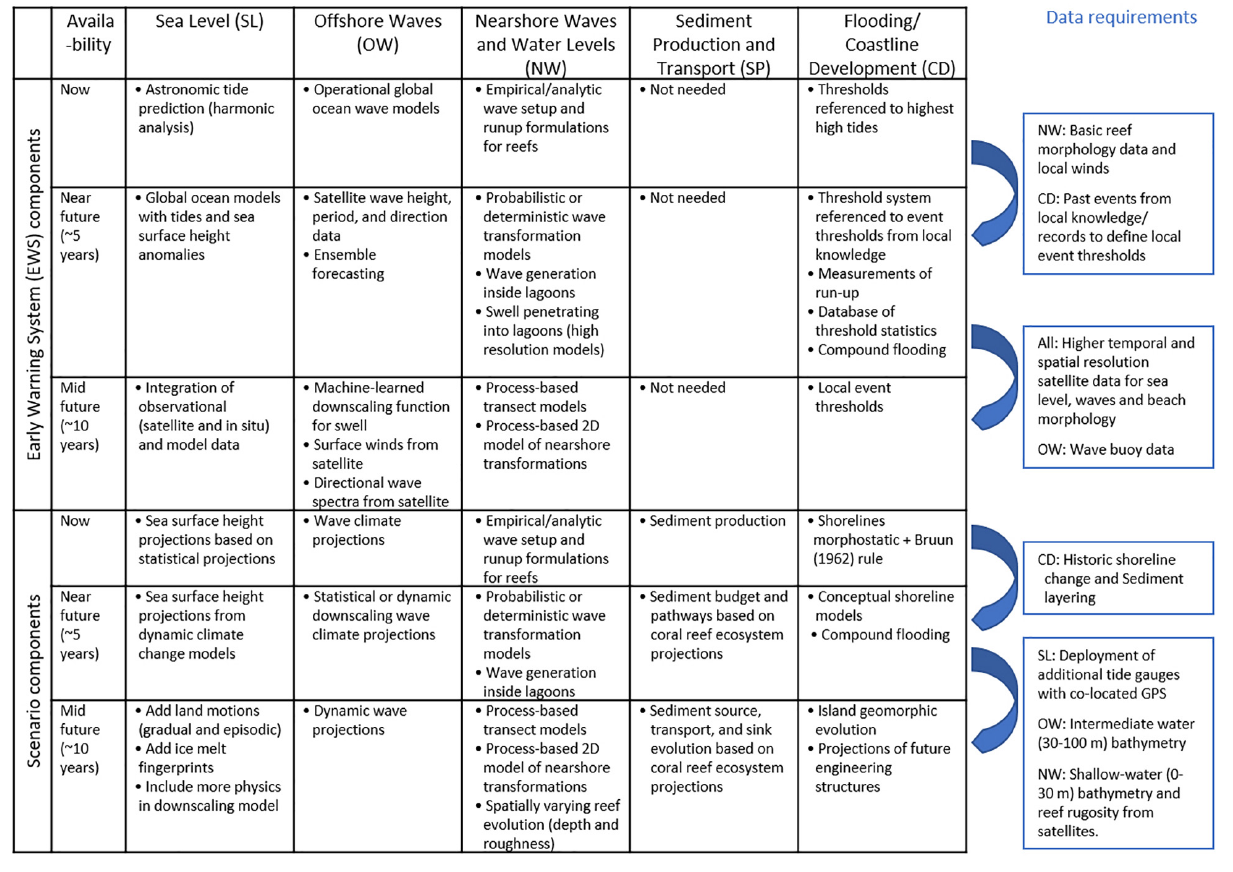
FIGURE 2 | Modules required to develop (top) a coastal flood Early Warning System (EWS) and (bottom) a scenario modeling tool, which can be implemented immediately (now), in the near-term, and in the long term. Blue boxes on the right describe key data gaps that need to be filled to develop the next generation of EWS or scenario modeling